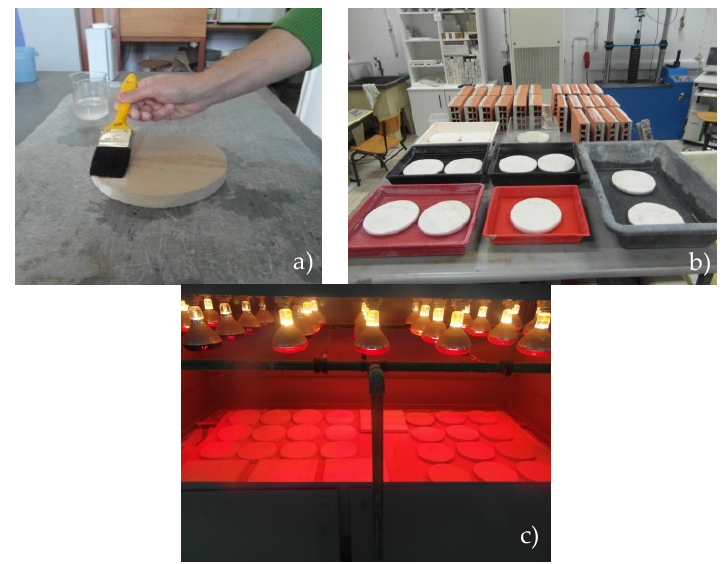
Figure 1. ( a ) Application of hydrophobic product on cylindrical limestone specimens; ( b ) capillarity water absorption on limestone and mortar specimens; ( c ) artificial aging test (hygrothermal cycles).